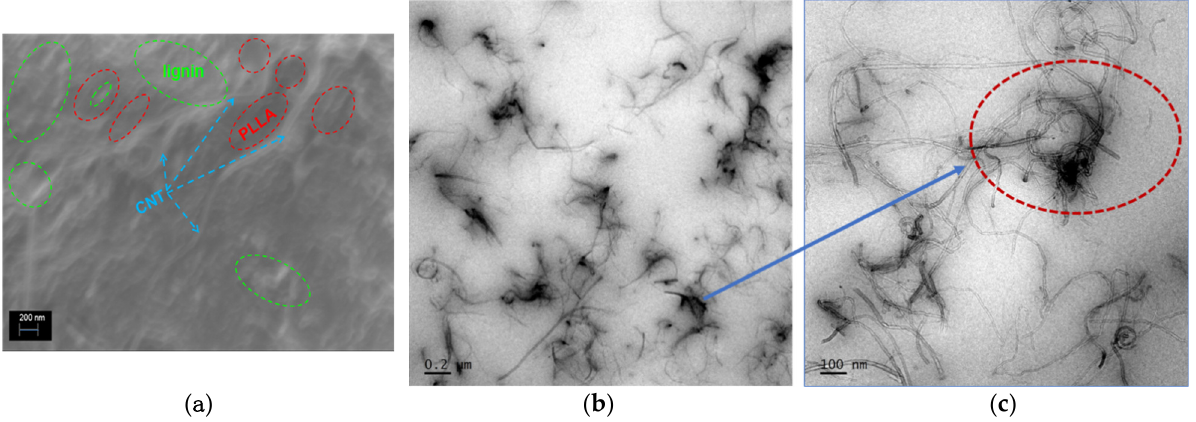
Figure 1. ( a ) FESEM image of PLLA_Lignin_MWCNT. PLLA matrix is indicated in red, and the areas containing lignin are shown in green. Blue arrows point at filament shapes, which are characteristic of MWCNT, ( b , c ) TEM images of